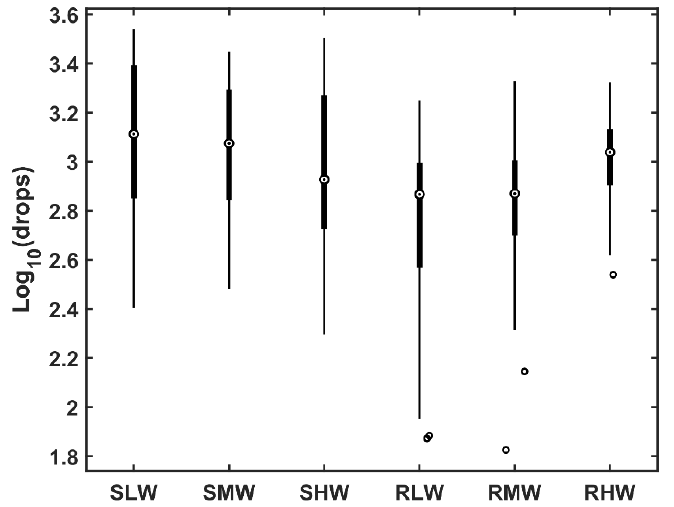
Figure 5. Boxplot of logNorm values for solid and liquid precipitation groups. White circles represent the median of the values for each subgroup while isolated points represent the outliers.